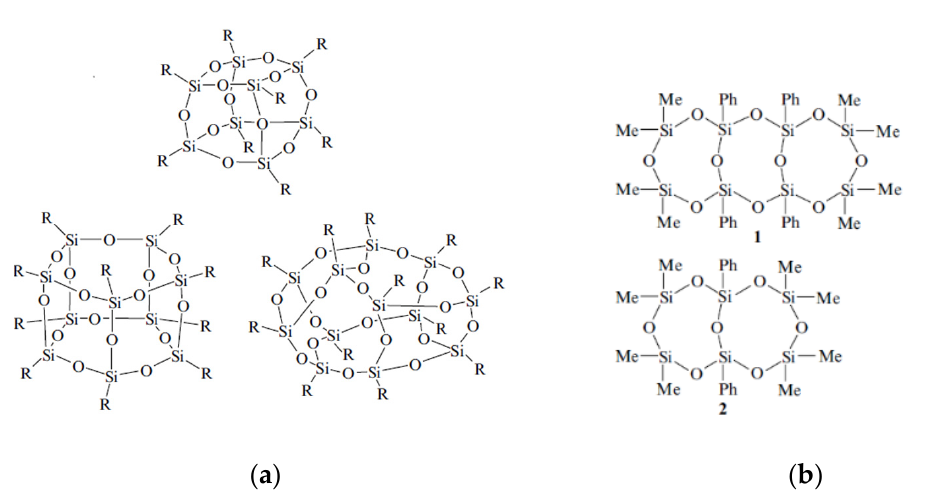
Figure 3. Structures of cyclic ( a ) and framework ( b ) silsesquioxane.